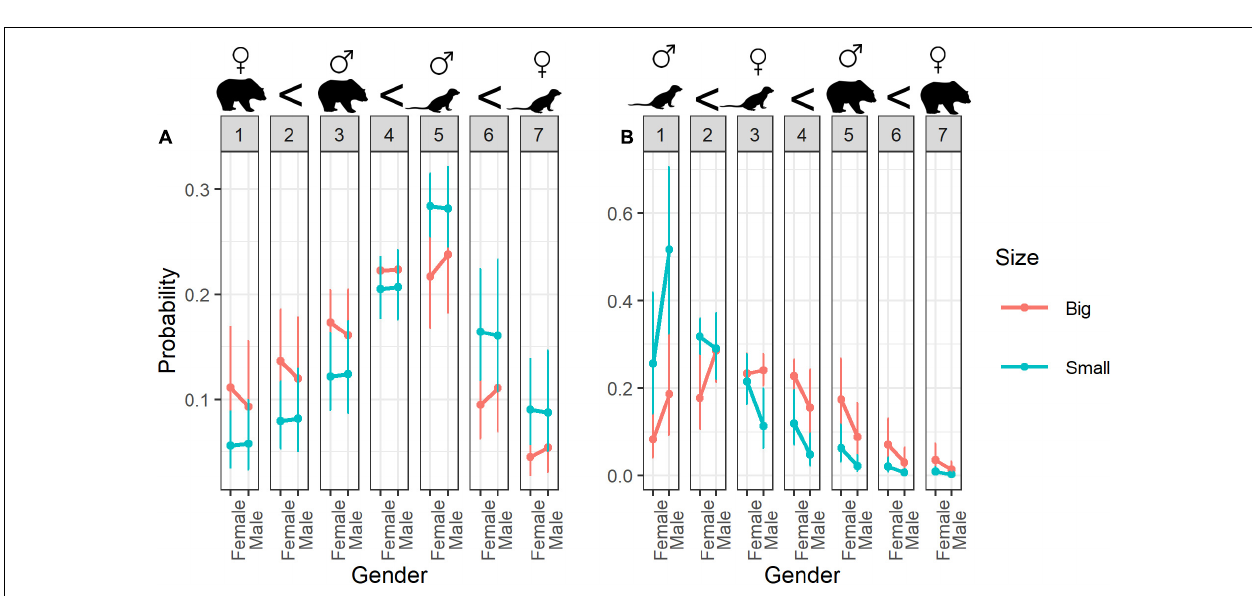
FIGURE 6 | Interaction effects of Gender:Size for (A) cuteness and (B) fear. Error bars indicate 95% confidence interval; numbers 1–7 refer to rating scores.